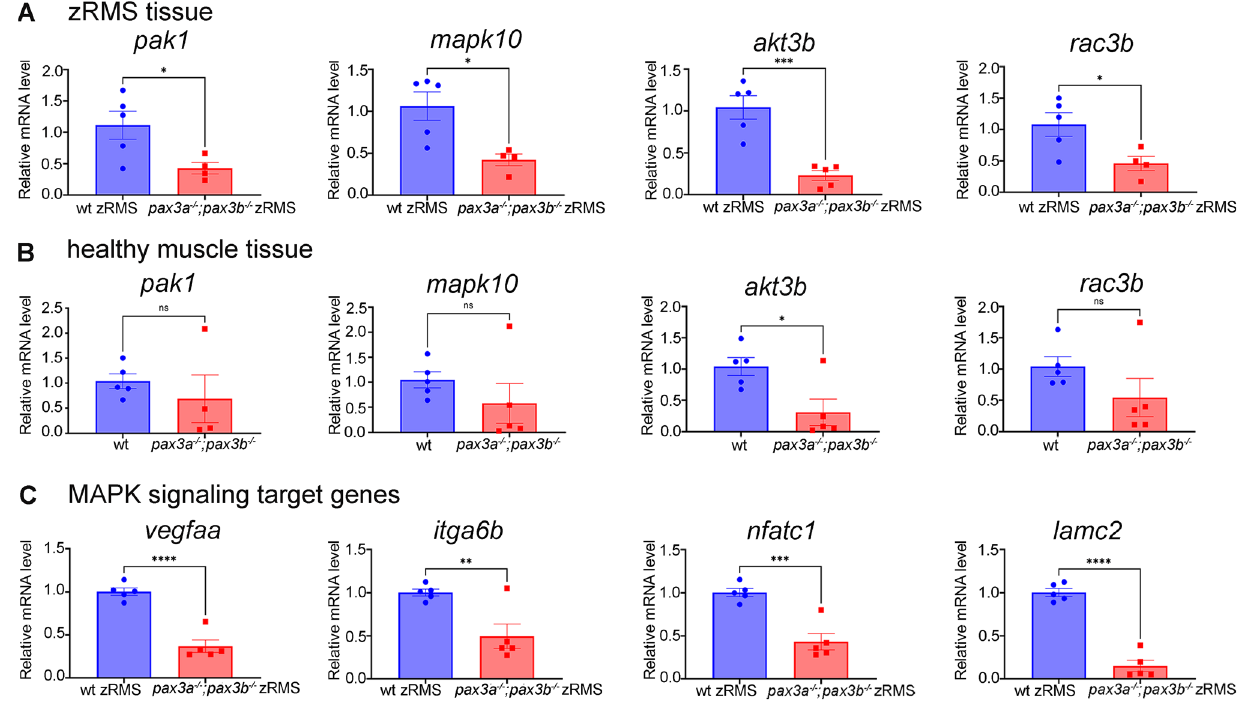
Figure 4. Semi-quantitative RT-PCR for genes linked to RAS/MAPK signalling pathways: (A) Relative mRNA expression of pak1 ( n = 4 pax3a −/− ;pax3b −/− zRMS) , mapk10 , akt3b and rac3b in pax3a −/− ;pax3b −/− ;pax3a:EGFP zRMS compared with wild type ( pax3a:EGFP) zRMS tissue from the similar age . (B) Relative mRNA expression of pak1( n = 4 pax3a −/− ;pax3b −/− ), mapk10 , akt3b and rac3b in pax3a −/− ;pax3b −/− ;pax3a:EGFP compared with wild type healthy muscle tissue from the similar age group. (C) Relative mRNA expression of vegfaa, itga6b, nfatc1 and lamc2 in pax3a −/− ;pax3b −/− ;pax3a:EGFP zRMS compared with wild type ( pax3a:EGFP) zRMS tissue . n = 5 in all samples unless otherwise stated. Error bars indicate mean ± SEM and significance was calculated using student t-test where p < 0.05 was considered significant, *p < 0.05, **p < 0.01, ***p < 0.001, ****p <